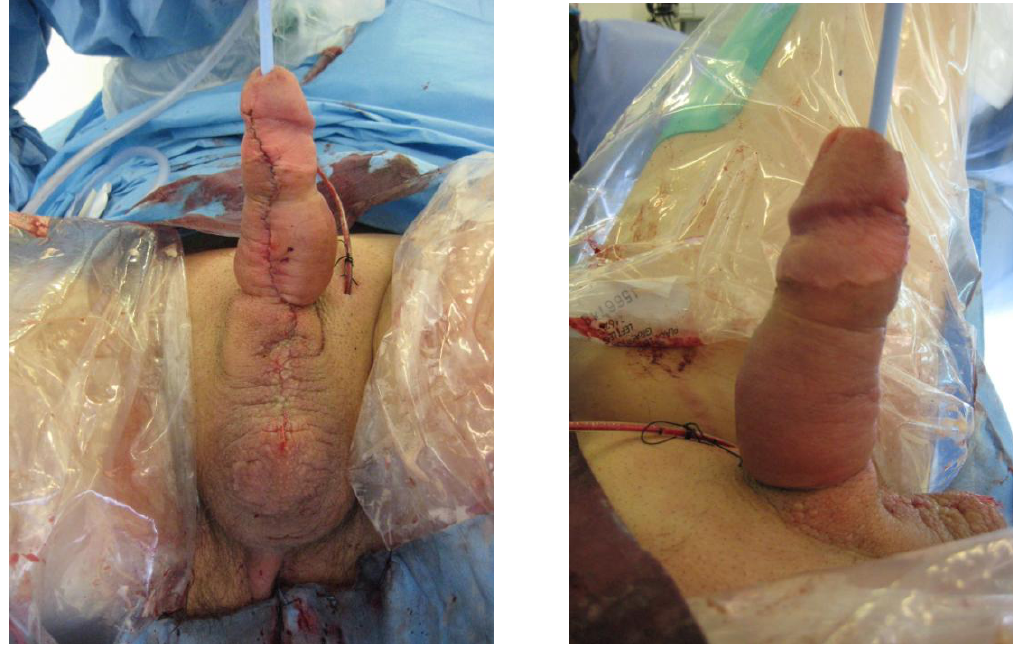
FIGURE 3 . Immediate postoperative result of a subcutaneous excision for penoscrotal